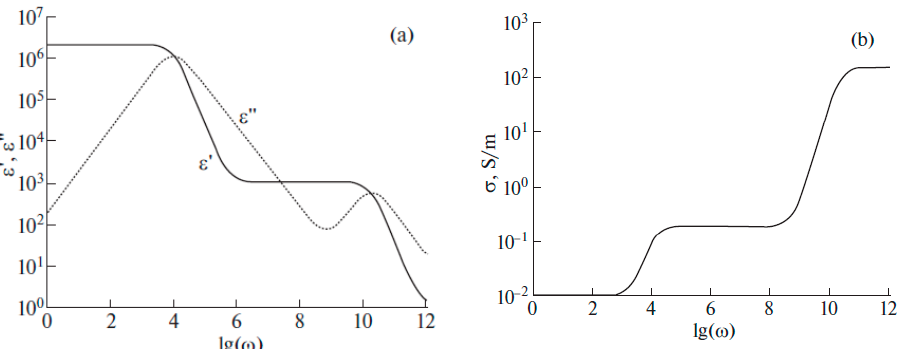
Figure 2. Frequency dependence of the real and imaginary parts of the relative dielectric permittivity ( a ) and conductivity ( b ) of biological tissue with averaged parameters calculated by the Debye formula.